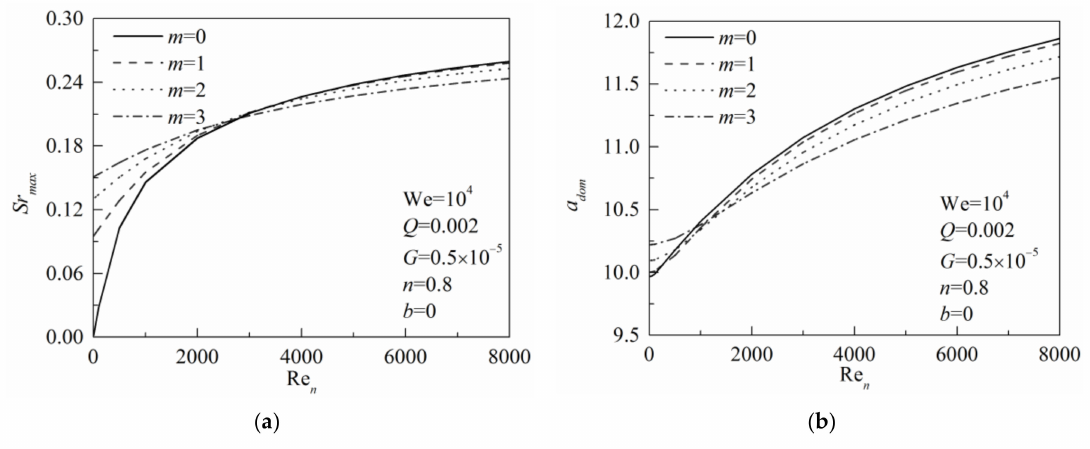
Figure 6. E ff ect of the generalized Reynolds number on the maximum growth rate ( a ) and the dominant wavenumber ( b ).